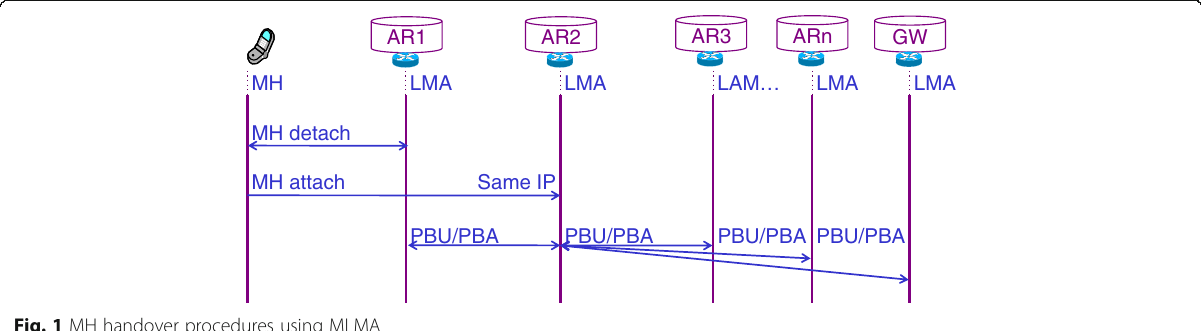
Fig. 1 MH handover procedures using